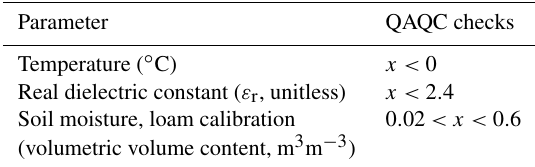
Table 3. QAQC flags for manual review. Parameter QAQC